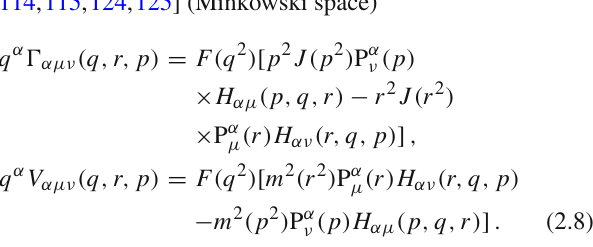
114,115,124,125] (Minkowski